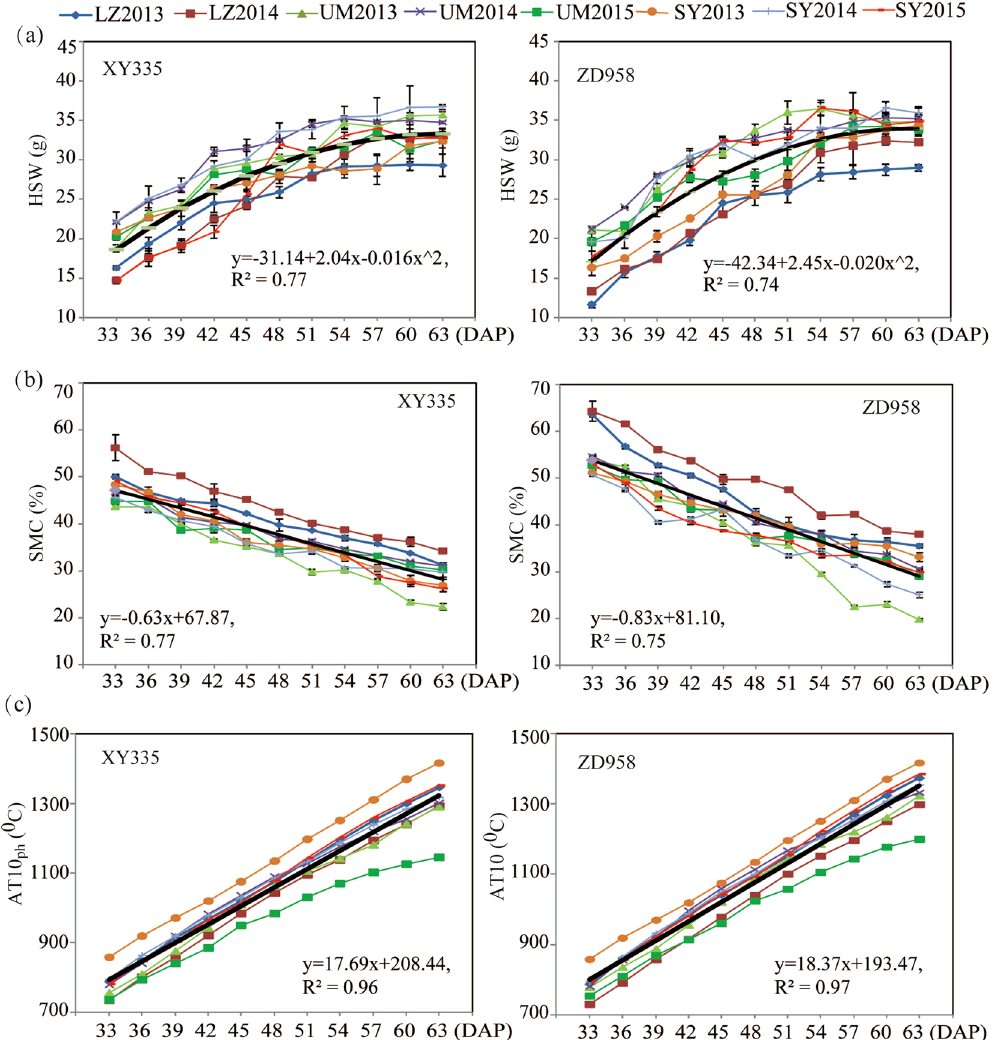
Figure 3. Performance of ( a ) hundred-seed weight (HSW), ( b ) seed moisture content (SMC) and ( c ) ≥ 10 °C accumulated temperature from pollination to harvest (AT10 ph ) in response to harvest stage in XY335 and ZD958 grown in 3 locations (LZ, UM and SY) over 2–3 years (2013, 2014 and 2015). The relationship between harvest stage and the investigated traits was simulated using the “quadratic”, “linear” and “linear-plateau” models in the SAS program. The results from the best-fit model are presented by black lines and equations.